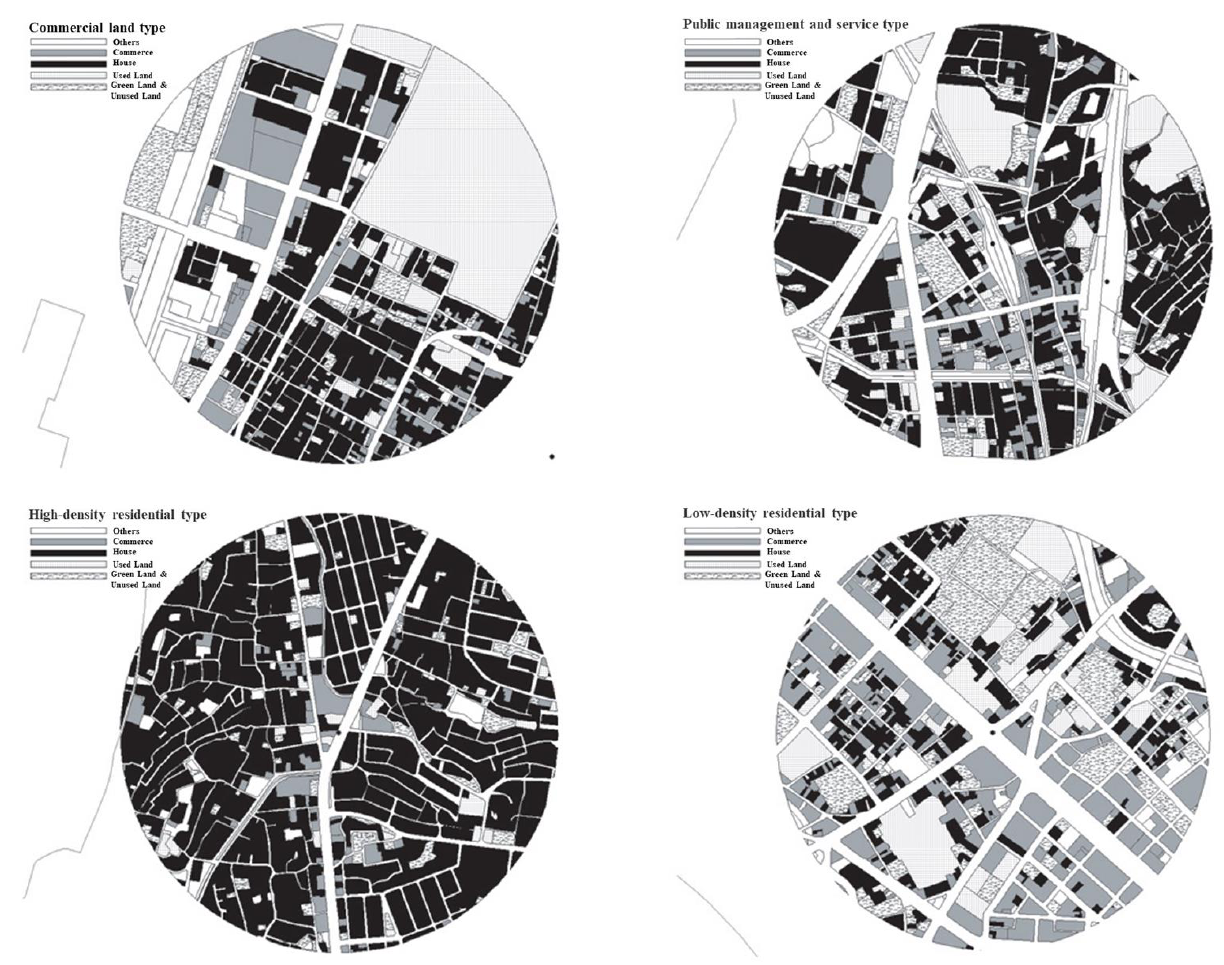
Figure 8. Typological maps of land use in station zones.